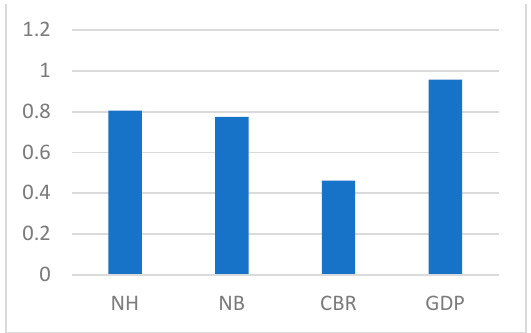
Figure 7. Total importance degree for each variable.